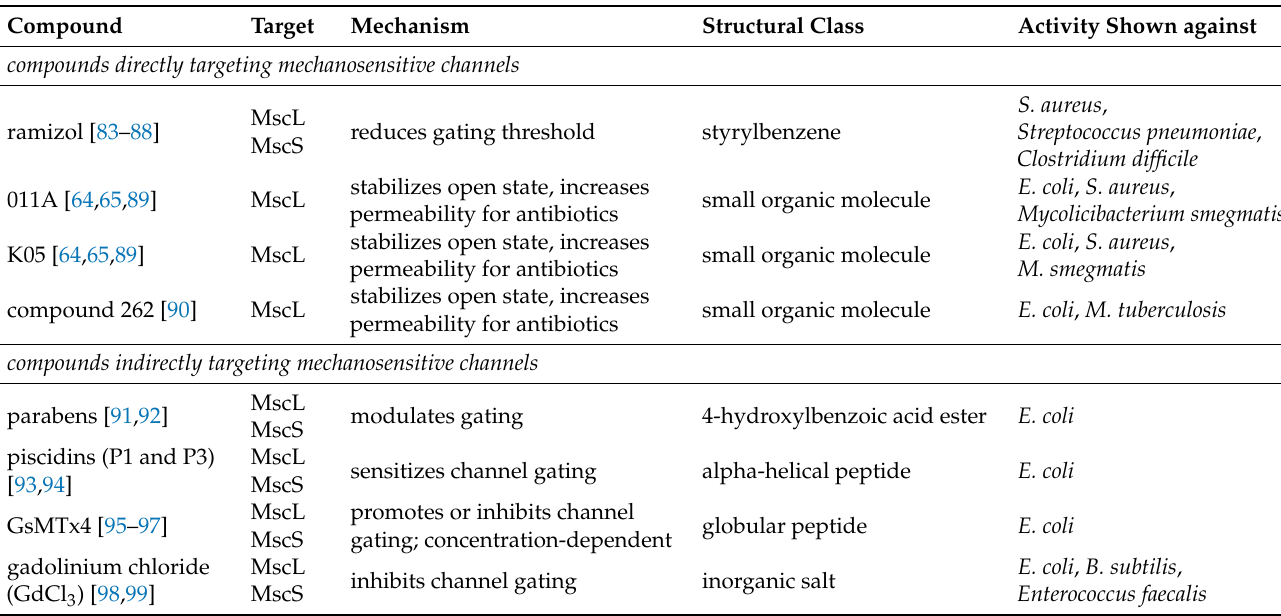
Table 2. List of known inhibitors and modulators of mechanosensitive-channel